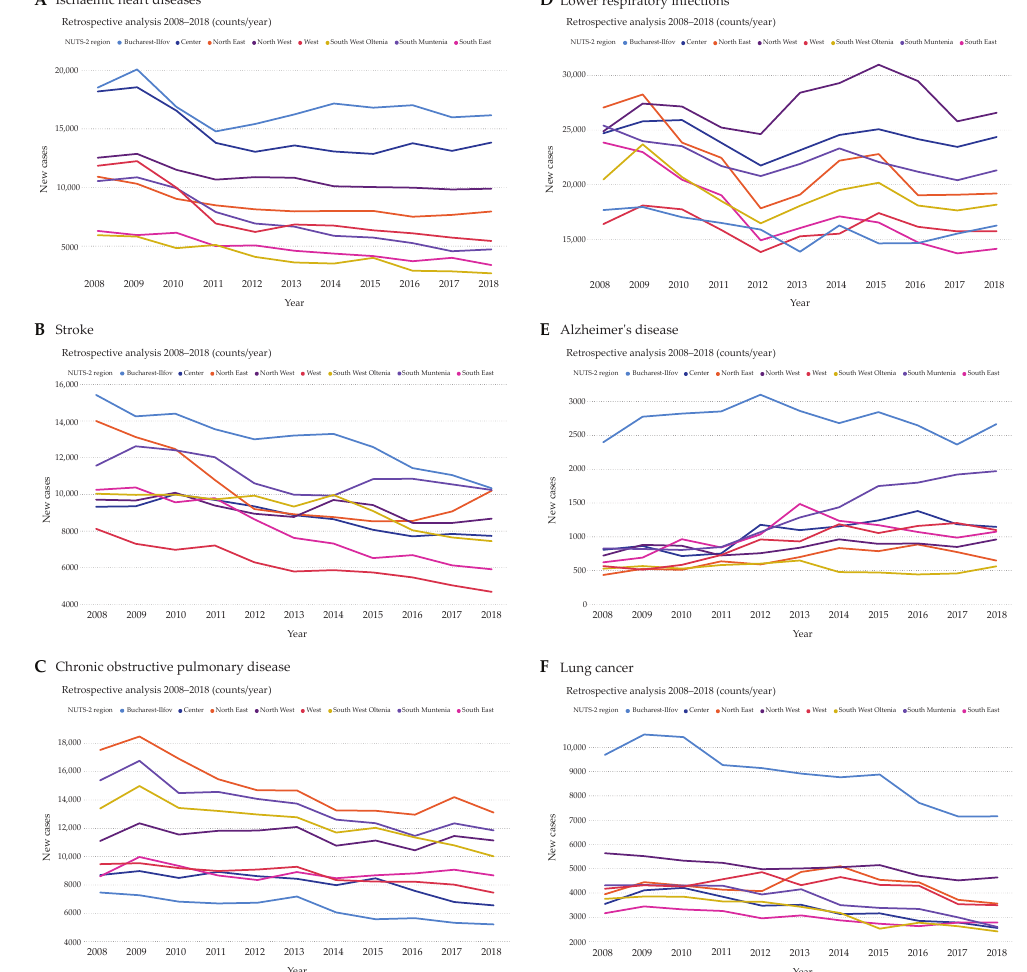
Figure 1. Total case counts of patients hospitalized due to ischemic heart diseases ( A ), stroke ( B ), chronic obstructive pulmonary disease ( C ), lower respiratory infections ( D ), Alzheimer’s disease ( E ), and lung cancer ( F ). Only diseases encoded as main diagnoses that facilitated hospitalization were counted for every NUTS 2 region of Romania per year over the period